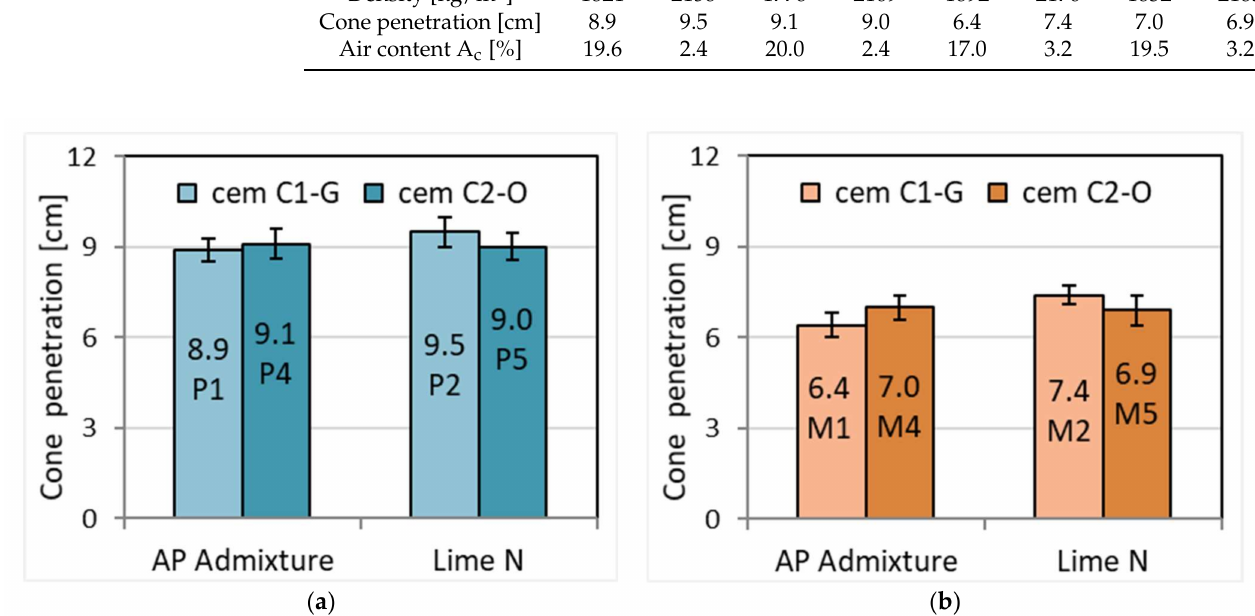
Figure 1. The effect of cement type and admixture type on the consistency of ( a ) plaster and ( b ) masonry